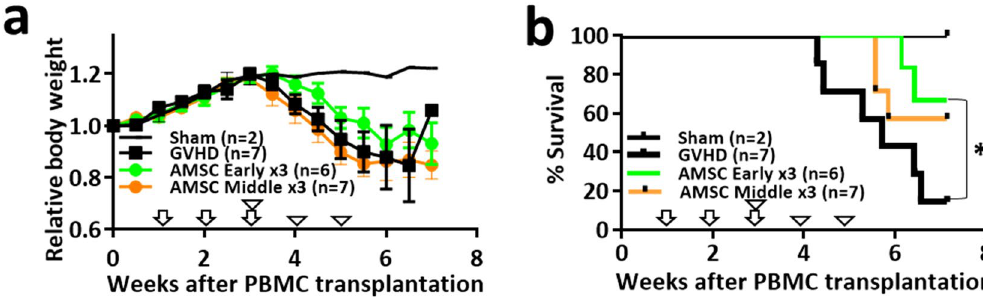
Figure 6. Early-phase administration of AMSC attenuate GVHD progression in xeno-GVHD mice. GVHD was induced by transplantation of 3 × 10 6 cells/mouse PBMC administered intravenously on week 0. Mice were administered 8 × 10 6 cells/kg AMSC intravenously three times in the early phase (weeks 1 ‒ 3, ↓ , n = 6) or middle phase (weeks 3 ‒ 5, ▽ , n = 7). Sham (n = 2) and GVHD control (n = 7) mice were administered vehicle. Data from one experiment are presented as mean ± SEM. ( a , b ) Relative body weight and survival rate. * P < 0.05 AMSC early versus